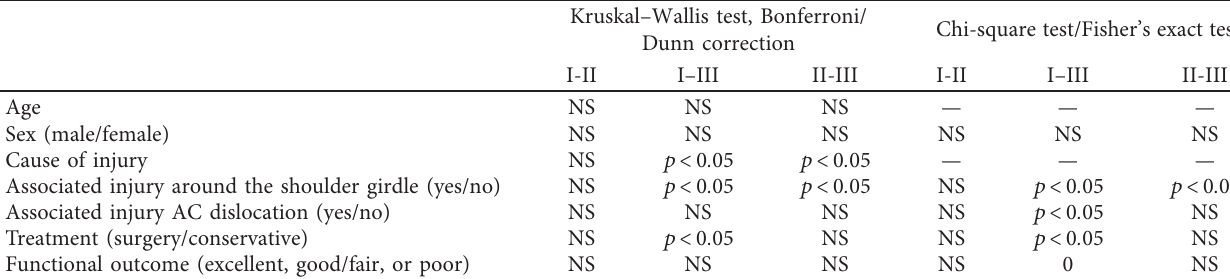
Figure 4: Representative anteroposterior radiograph: three-dimensional computed tomography reconstruction (a), Type III injury (b), anteroposterior radiograph two years postoperatively (c), and axillary radiograph two years postoperatively (d). This image was used with permission from Kurume University Medical Center and Dr. K. Nakama Table 3: Results of statistical analysis.